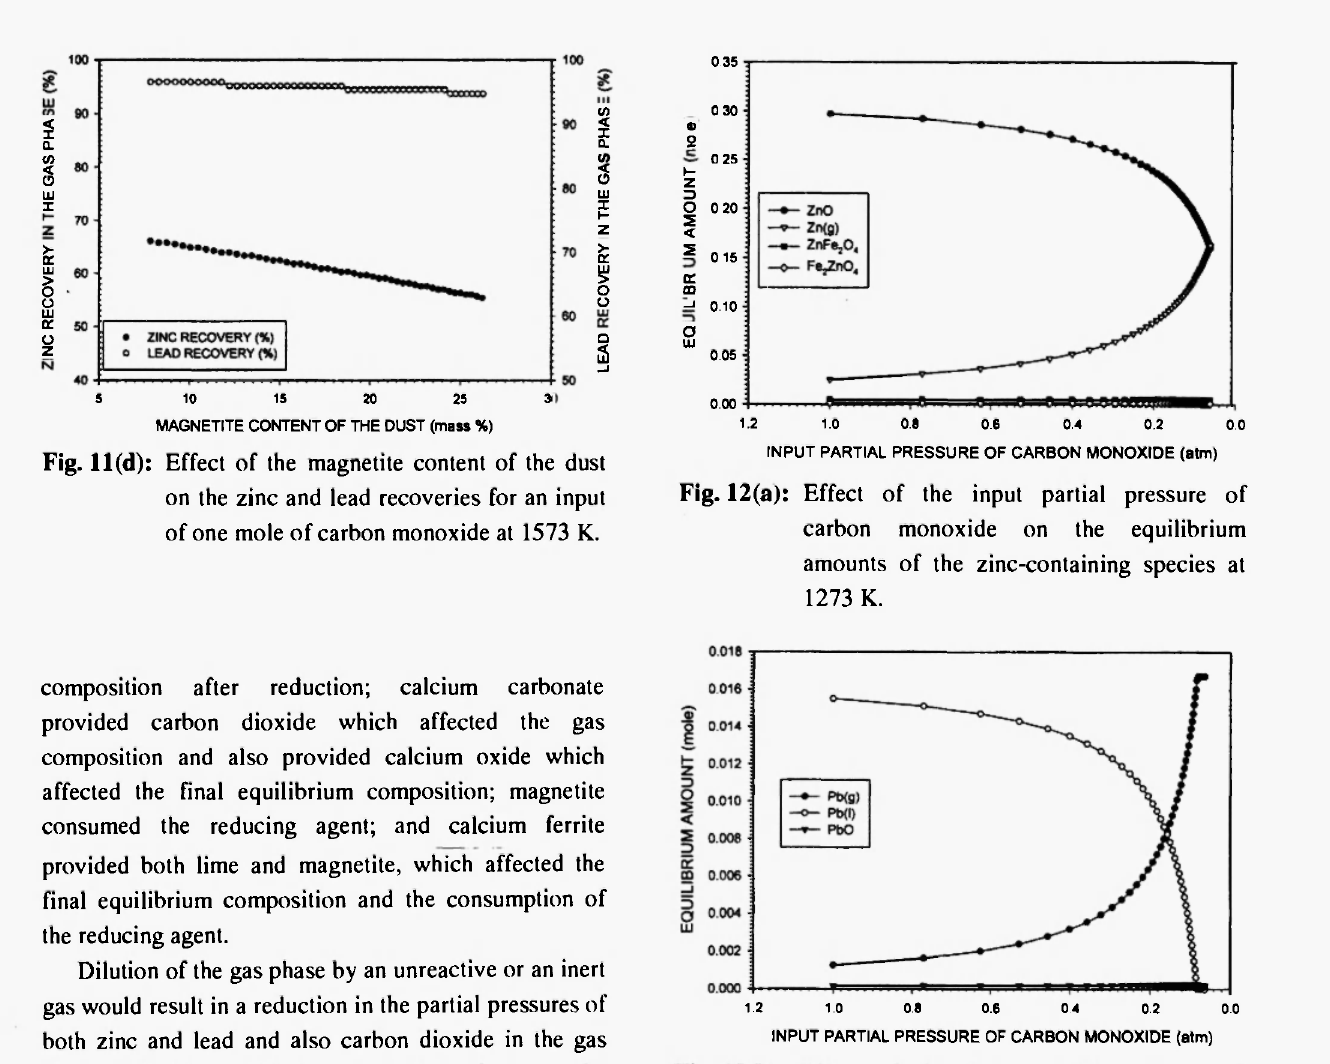
Fig. 12(b): Effect of the input partial pressure of carbon monoxide on the equilibrium amounts of the lead-containing species at 1273